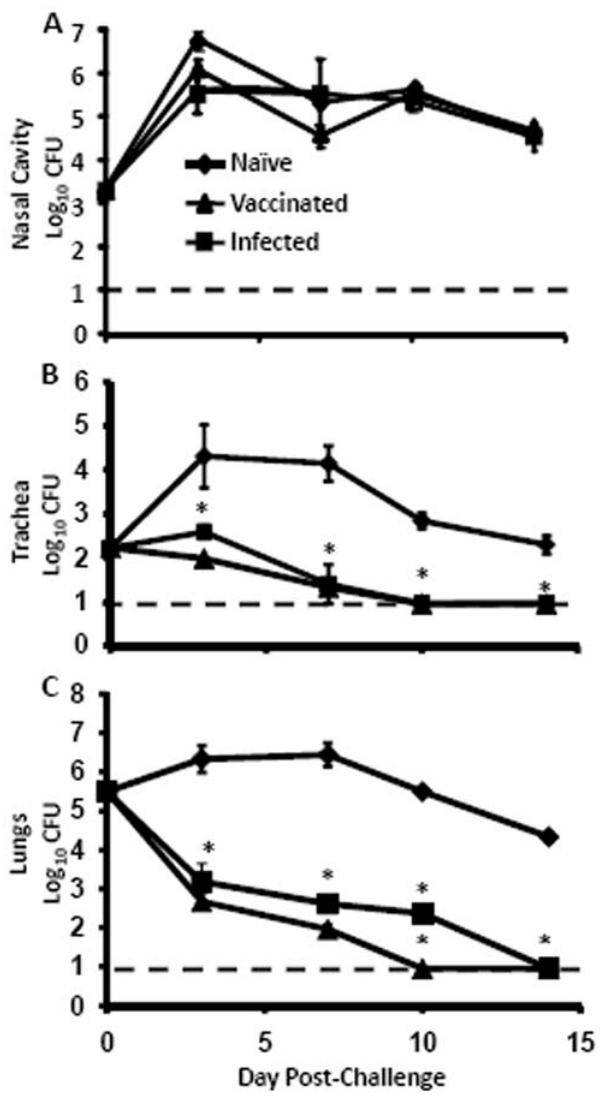
Figure 1. B.bronchiseptica numbers in the respiratory tract of naı¨ve and B.pertussis immune mice over time. Groups of 3 to 4 C57BL/6 mice were left uninoculated ( ¤ ), inoculated with 5 6 10 5 CFU of B. pertussis ( & ), or vaccinated with 2 i.p. injections of 10 8 heat killed B. pertussis on Days 0 and 14 ( m ). On Day 21, mice were gentimicin- treated for 3 days. Mice were then challenged with a gentimicin R strain of B. bronchiseptica on Day 28 and sacrificed at the indicated day post- challenge for quantification of bacterial load in nasal cavity (A), trachea (B) and the lungs (C). Bacterial numbers are represented as the mean Log 10 CFU + / 2 SEM. Dashed line represents the lower limit of detection. * indicates statistical difference ( P value , 0.05) between naı¨ve and treated groups.